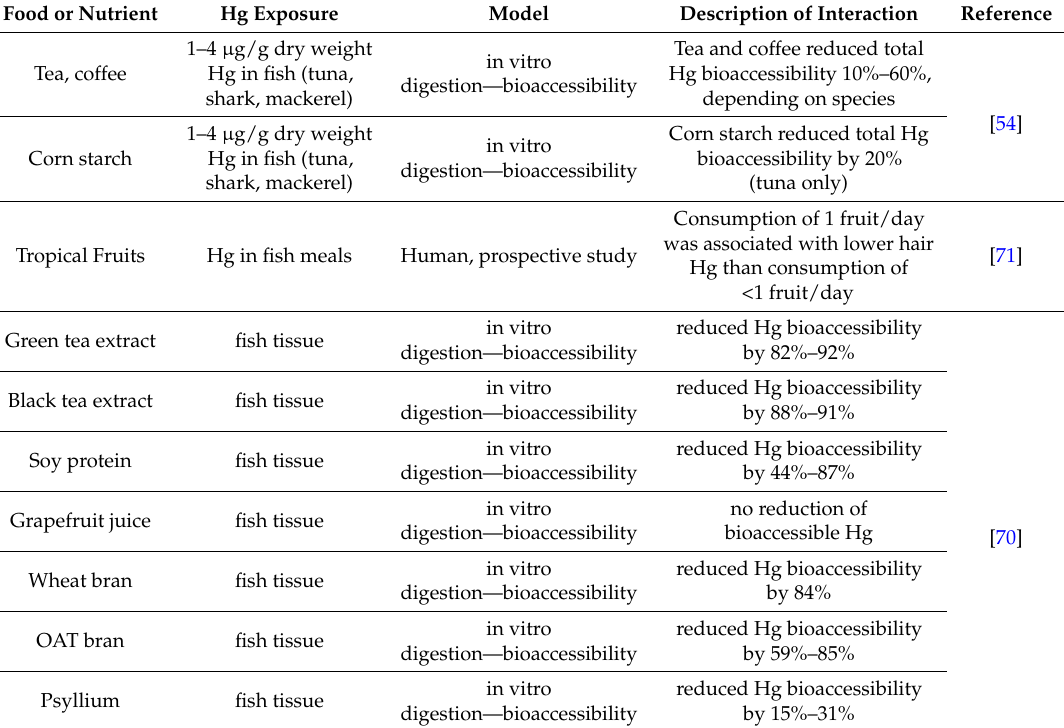
Table 2. Recent examples of nutrients/foods with effects on gut-relevant transport of